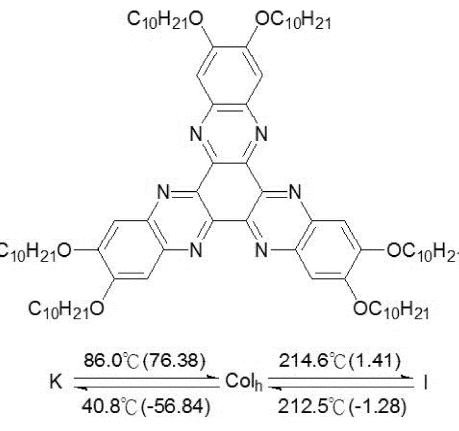
Figure 2. Chemical structure and phase sequence of 2,3,8,9,14,15-hexakis(decyloxy)- diquinoxalino-[2,3-a:2’3’-c]phenazine